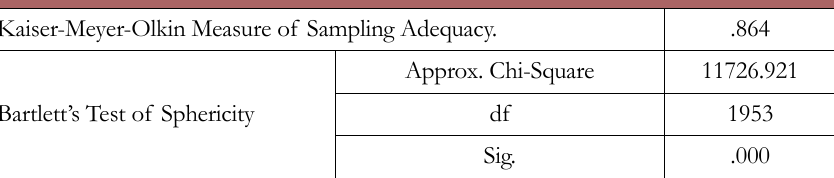
Table 2. Sample adequacy test through KMO and Bartlett’s